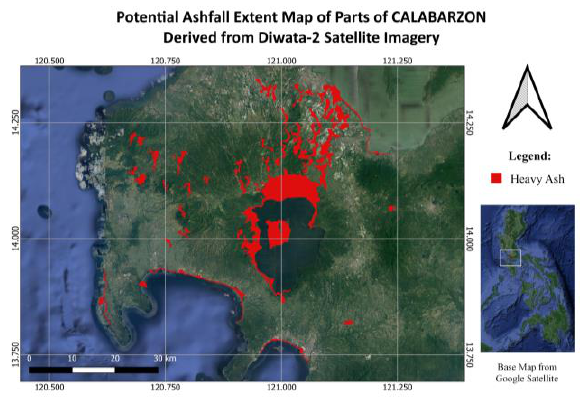
Figure 5. Map of the potential ash dispersal over parts of CALABARZON based on Diwata-2 satellite